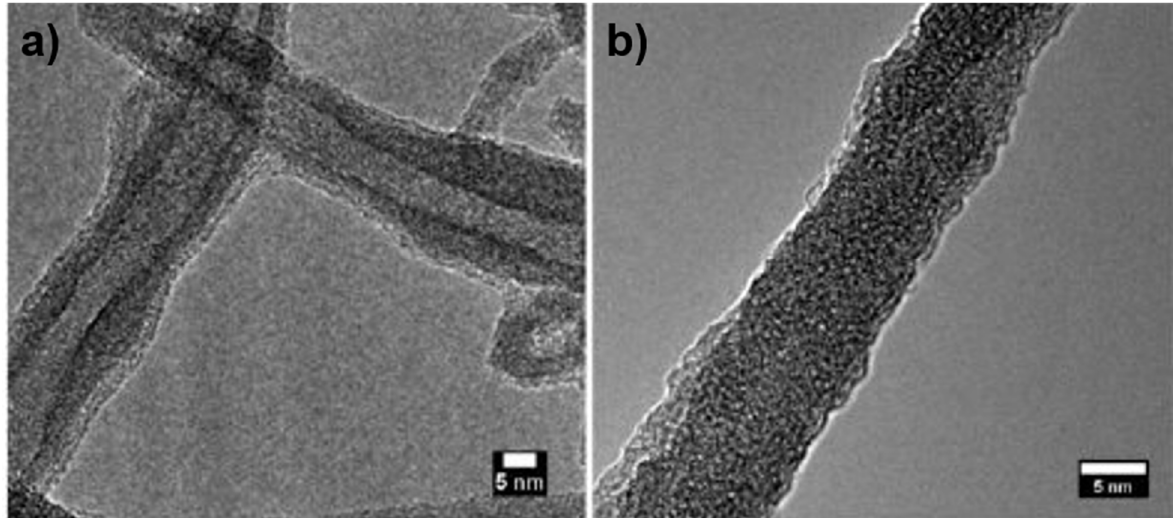
Figure 7. TEM images of P1-templated TiO 2 nanotubes ( a ) and P2-templated TiO 2 nanowires ( b ) obtained after calcination, adapted from [95], with permission of the Royal Society of Chemistry.